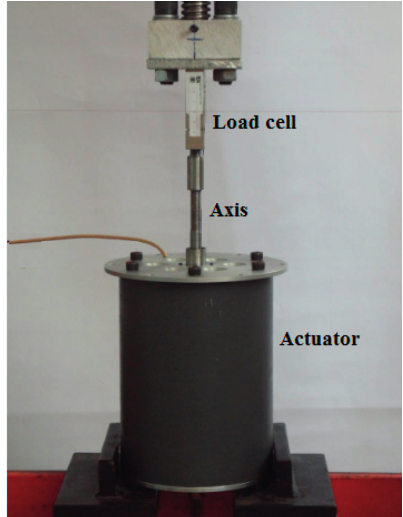
Figure 15. Prototype placed on the test bench for the measurement of static axial force by a load cell.